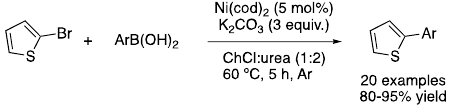
Figure 23. Ni-catalyzed Suzuki-Miyaura coupling.